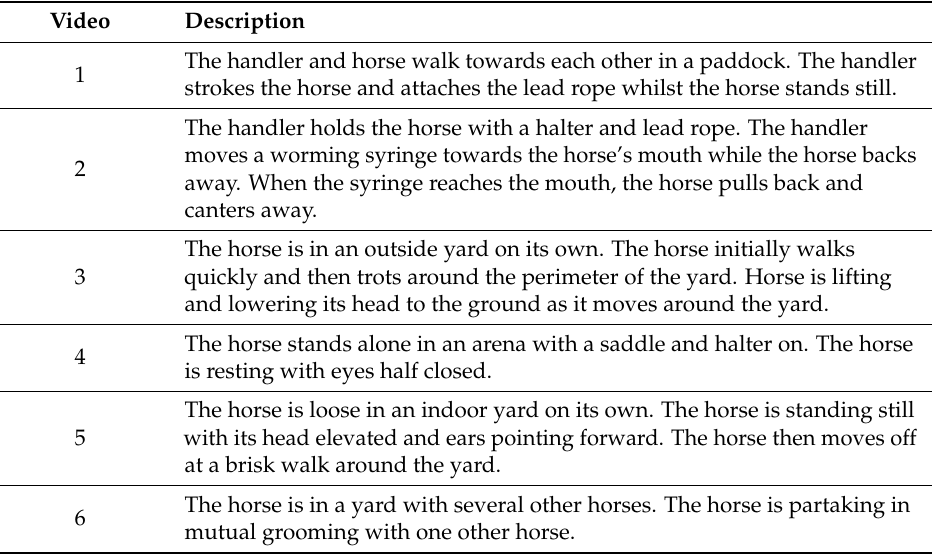
Table 1. Descriptions of the six videos used in a study to assess students’ interpretation of expressive horse behaviour.